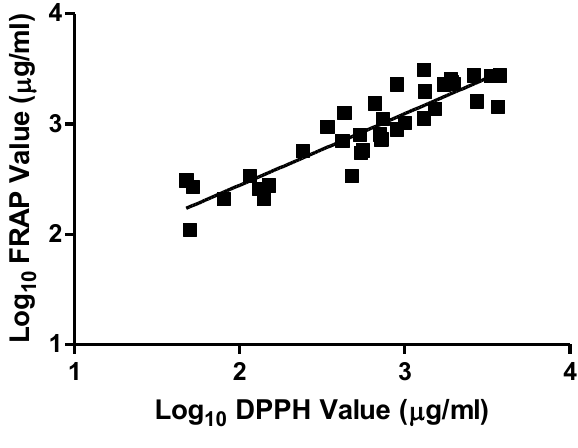
Figure 1. Correlation of DPPH value (as EC in μg/mL) for the 36 plant extracts indicated in Table 1 with EC than 4000 μg/mL, presented on log